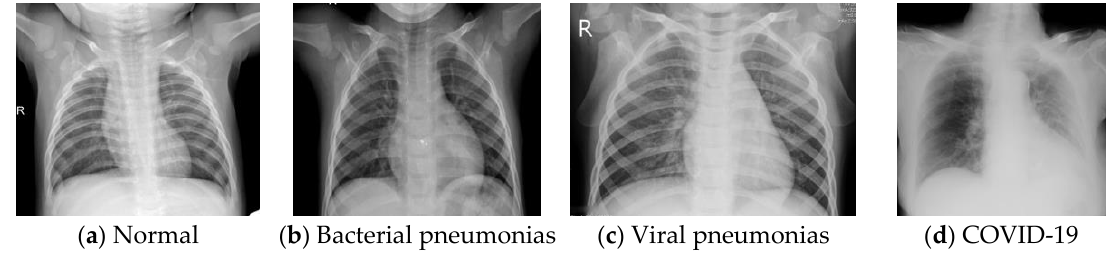
Figure 1. Sample of images from DB1.